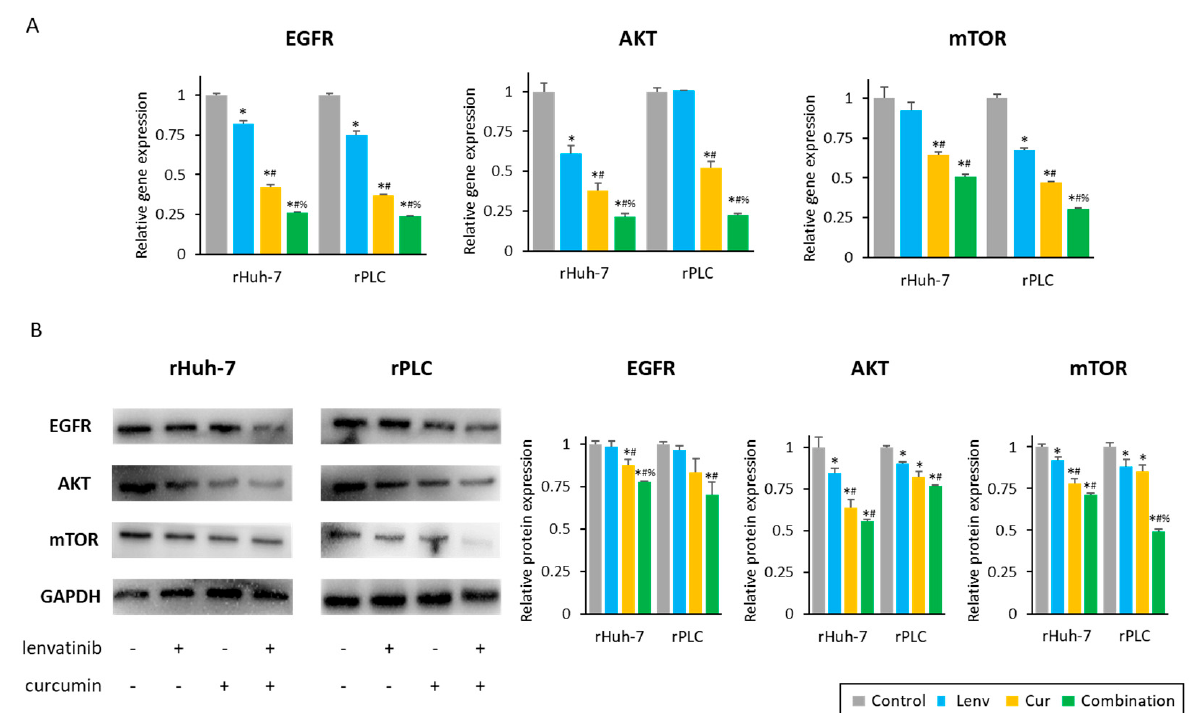
Figure 6. A combination of Curcumin and Lenvatinib downregulated the activity of EGFR and its downstream signaling pathway in Lenvatinib-resistant cells. ( A ) Gene expression changes of EGFR, AKT, and mTOR genes (*: p < 0.05 vs. control, #: p < 0.05 vs. Lenvatinib, %: p < 0.05 vs. Curcumin). ( B ) Western blotting of EGFR, AKT, and mTOR expression in Huh-7 and PLC-PRF-5 cell lines. GAPDH was used as an internal control protein (*: p < 0.05 vs. control, #: p < 0.05 vs. Lenvatinib, %: p < 0.05 vs. Curcumin). The data indicate mean (column) ± SD values. SD, standard